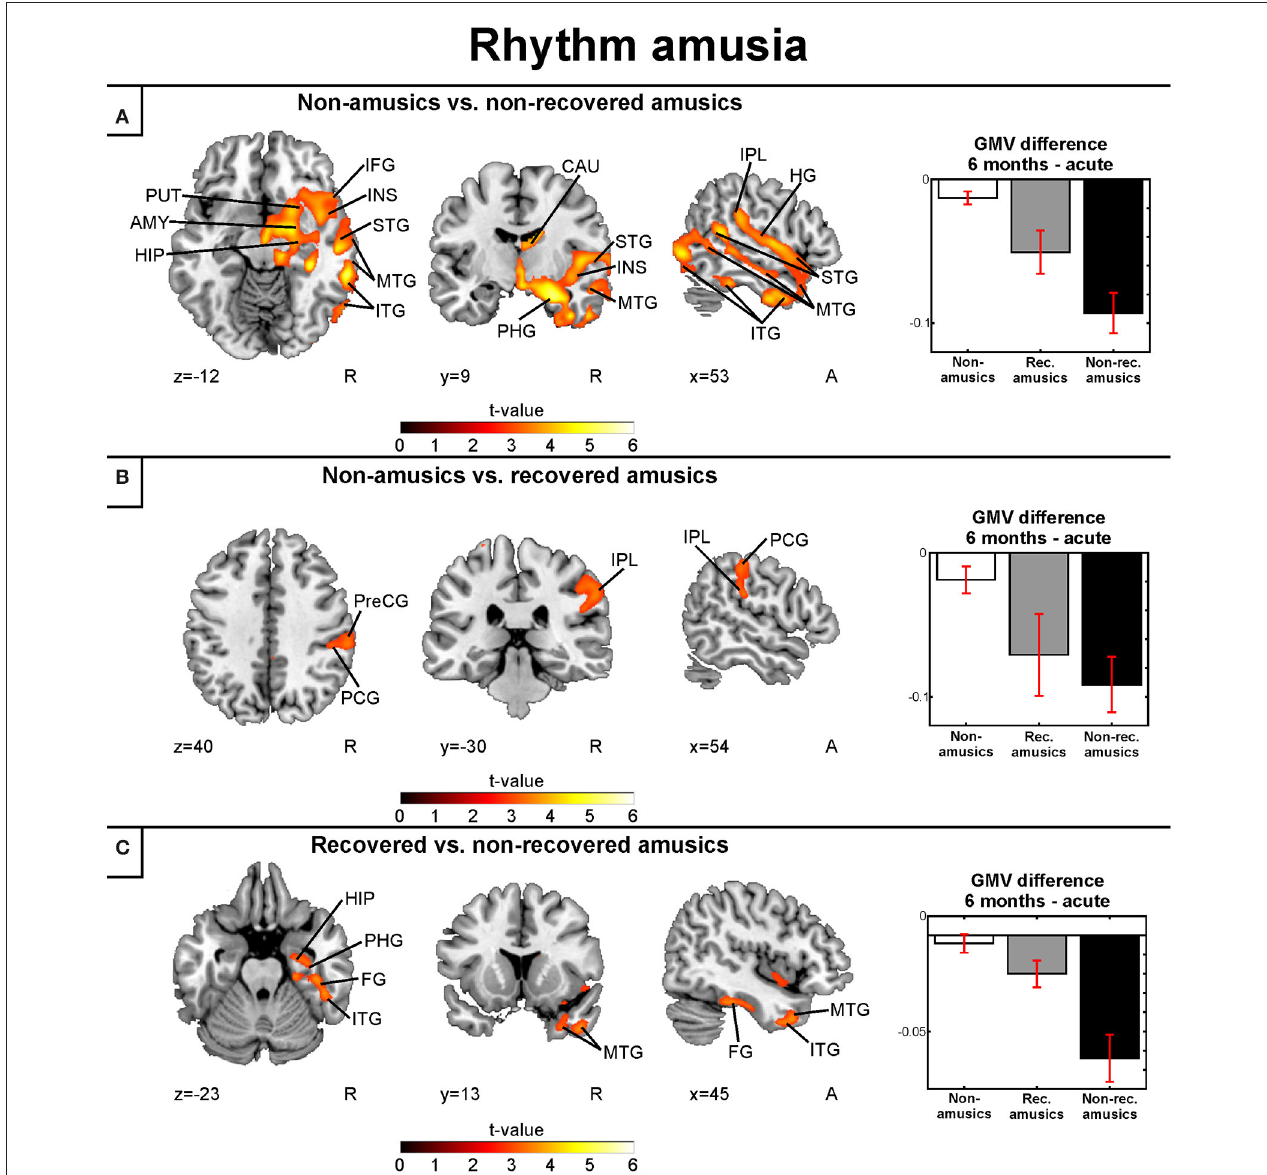
FIGURE 7 | Gray matter VBM results of pooled analysis: rhythm amusia. Time (6 months > Acute) × Group interactions for gray matter volume. (A) Non-amusic vs. non-recovered amusics; (B) Non-amusic vs. recovered amusics; (C) Recovered vs. non-recovered amusics. Results are thresholded at a whole-brain uncorrected p < 0.005 at the voxel level (extent threshold: k > 100 voxels) using MNI coordinates. Only clusters surviving an FWE-corrected p < 0.05 threshold are reported and labeled (see also Table 6 ). Bar plots for GMV differences in 6 months—Acute in significant clusters ( Table 6 ) are shown: bar = mean, error-bar = standard error of the mean. AMY, Amygdala; CAU, caudate; FG, fusiform gyrus; HG, Heschl’s gyrus; HIP, hippocampus; IFG, inferior frontal gyrus; ITG, inferior temporal gyrus; INS, insula; IPL, inferior parietal lobule; ITG, inferior temporal gyrus; MTG, middle temporal gyrus; PCG, postcentral gyrus; PHG, parahippocampal gyrus; PreCG, precentral gyrus; PUT, putamen; STG, superior temporal